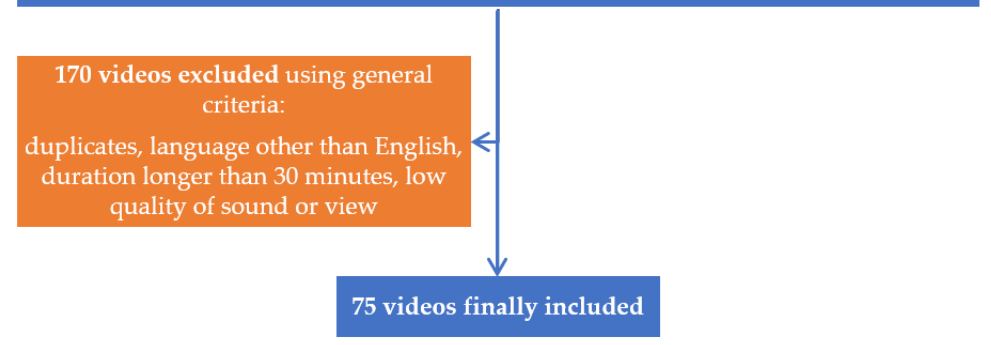
Figure 1. Flowchart shows selection of YouTube videos for the